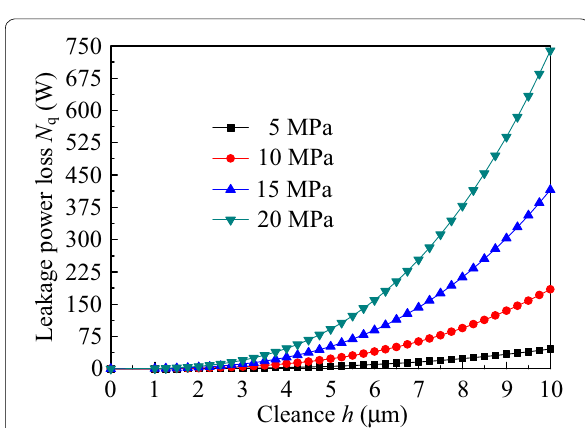
Figure 5 Change of leakage power loss with clearance